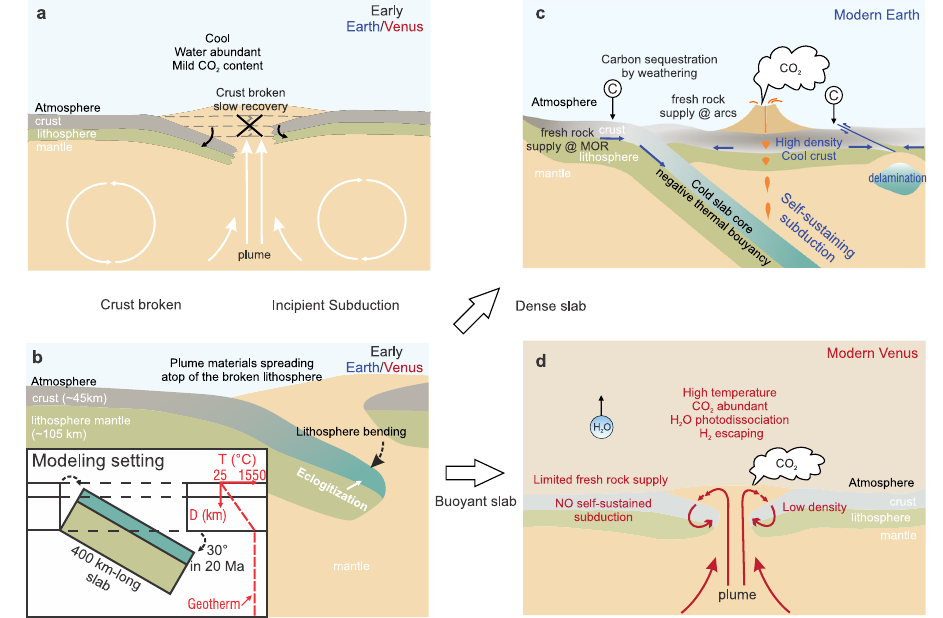
Fig.1|SchematiccartoonsillustratingtectonicevolutionsonEarthandVenus, and their diverging carbon cycles. a Plume upwelling breaks the lithosphere. b Incipient slab dipping on Venus and Earth; eclogitization might trigger self- sustaining subduction. The inset diagram displays the subduction setting